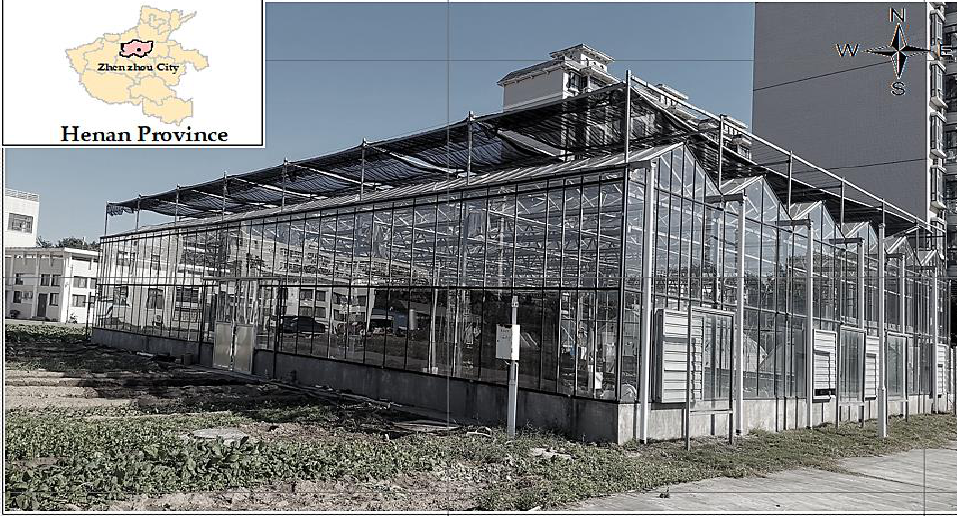
Figure 1. Schematic diagram of the appearance of the glasshouse experiment area.